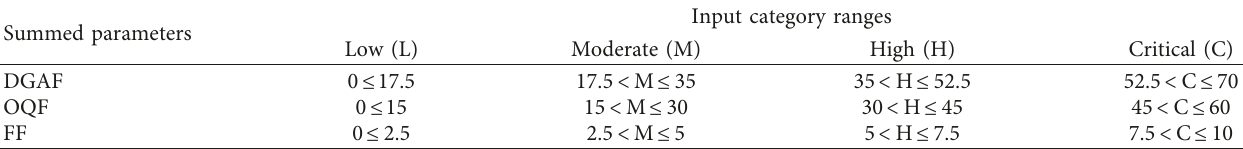
Figure 5: Fuzzy logic model for operational ageing stress. Table 4: Ranges obtained for summed parameters.